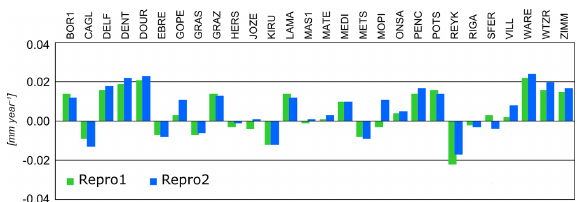
Figure 11. Differences of the trend value between the 18-year and the 16-year time series, for the Repro1 (green) and the Repro2 (blue)